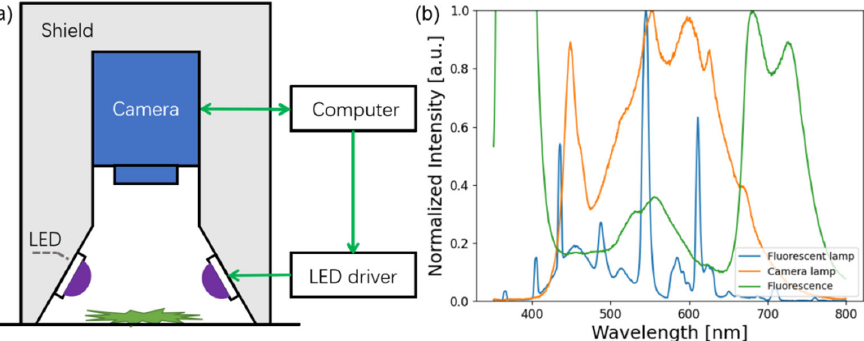
Figure 1. ( a ) Schematic diagram of fluorescence imaging device. The LEDs, LED driver, and shield were removed when taking images under white light. ( b ) Spectra of fluorescent lamp (blue line), smartphone camera lamp (orange line), and tea fluorescence spectrum under excitation of 370 nm LED (green line). Spectra were normalized to their maximum amplitude after 450 nm, respectively.